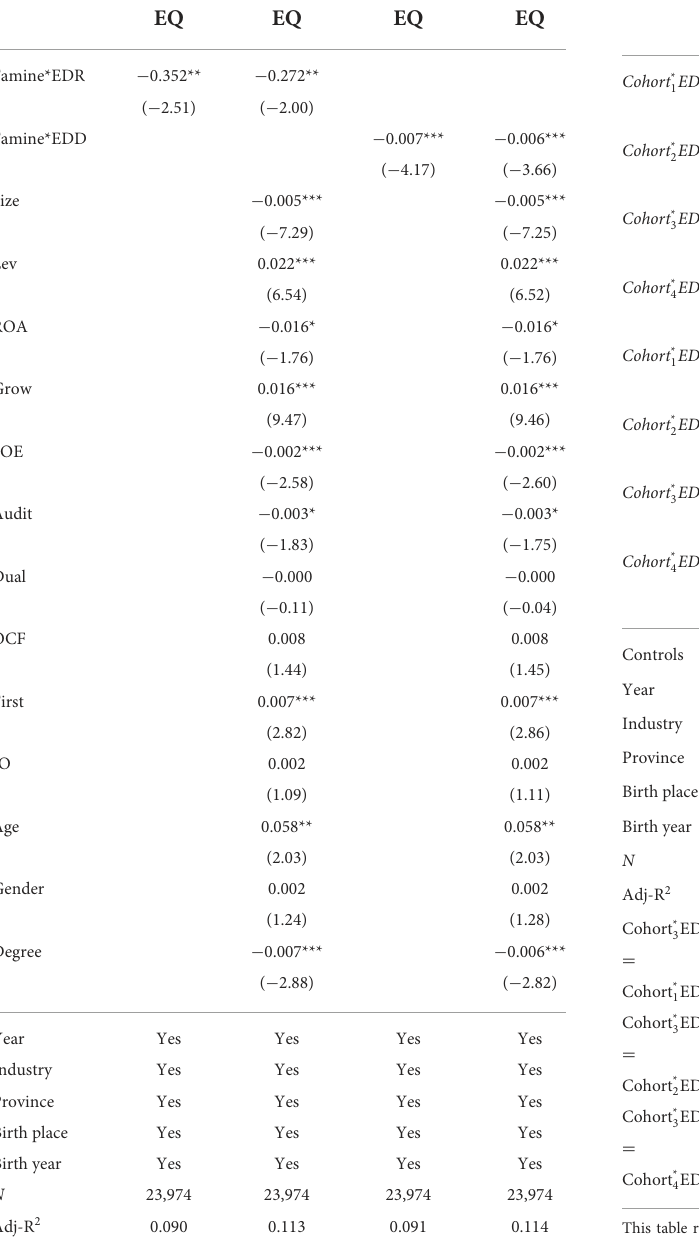
TABLE 4 Regression results of CEOs’ famine experience and corporate earnings quality.